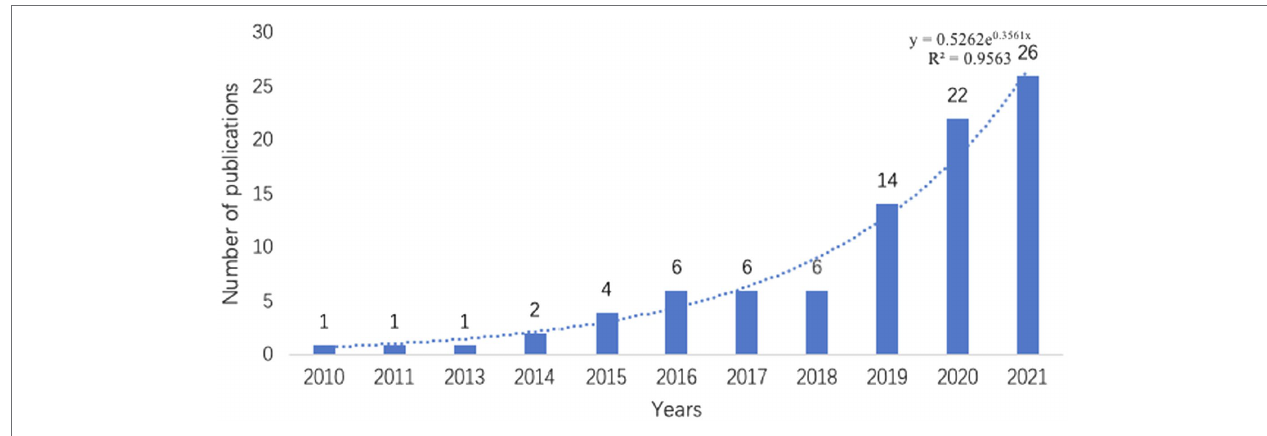
FIGURE 2 | Annual output of UPB